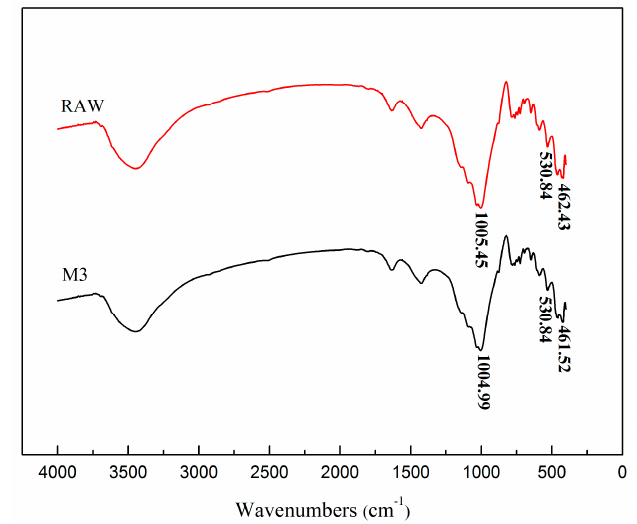
Figure 9. Fourier transform infra-red (FTIR) spectra of raw copper-mine tailings and Sample M3 (after 3 h of grinding).